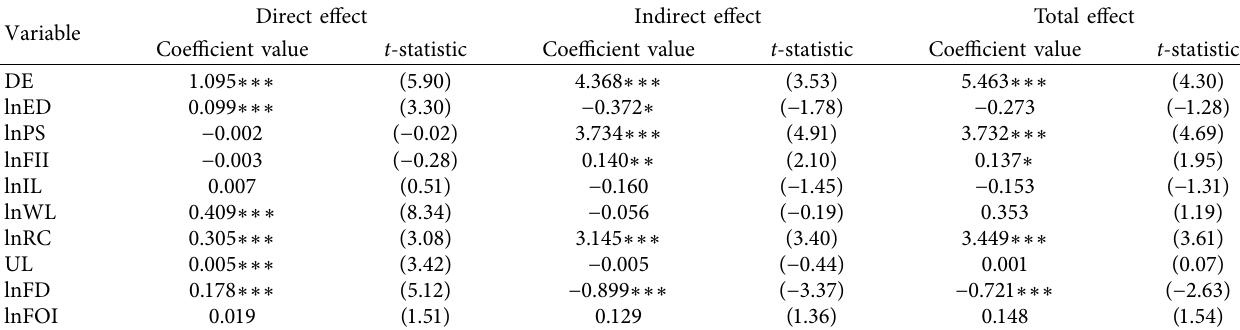
Table 5: Results of decomposition of the spatial effects of digital economy on urban innovation.